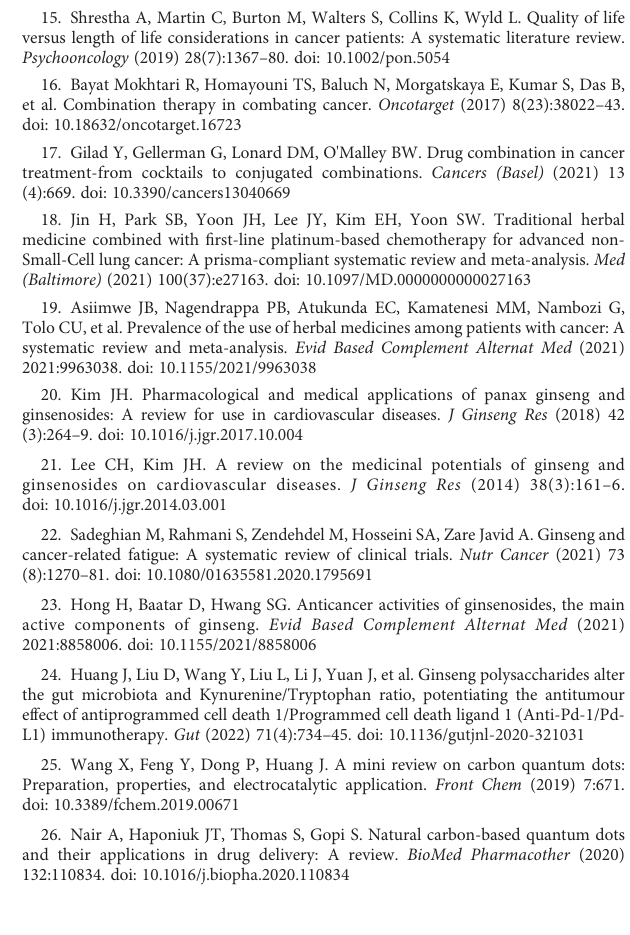
SUPPLEMENTARY FIGURE 1 Histological examinations of heart, liver, spleen, and kidney in the control and ginseng-based carbon dots (GCDs)-treated mice. SUPPLEMENTARY FIGURE 2 In fi ltration of immune cells in the tumors of mice treated or not with ginseng- based carbon dots (GCDs). (A) CD4 + lymphocytes. (B) Regulatory T cells. (C) Quanti fi cation of A and B. Data are presented as mean ± SD from three experiments. * P<0.05. SUPPLEMENTARY FIGURE 3 Live/dead cell staining of RCD treated Cal-27 cells, red fl uorescence represents dead cells, green fl uorescence represents live cells. SUPPLEMENTARY FIGURE 4 Quanti fi cation of ROS expression of . Data are presented as mean ± SD from three experiments. * P<0.05. SUPPLEMENTARY FIGURE 5 ROS expression by fl ow cytometry. (A) Images of ROS expression by fl ow cytometry in Cal-27 cells treated with concentrations of GCDs with 500 m g/ mL. (B) Quanti fi cation of ROS expression. Data are presented as mean ± SD from three experiments. * P<0.05. SUPPLEMENTARY FIGURE 6 RNA sequencing of cells treated with ginseng-based carbon dots (GCDs). (A, B) Bubble plot of GO and KEGG analysis for all gene rates with altered expressions in Cal-27 cells treated with